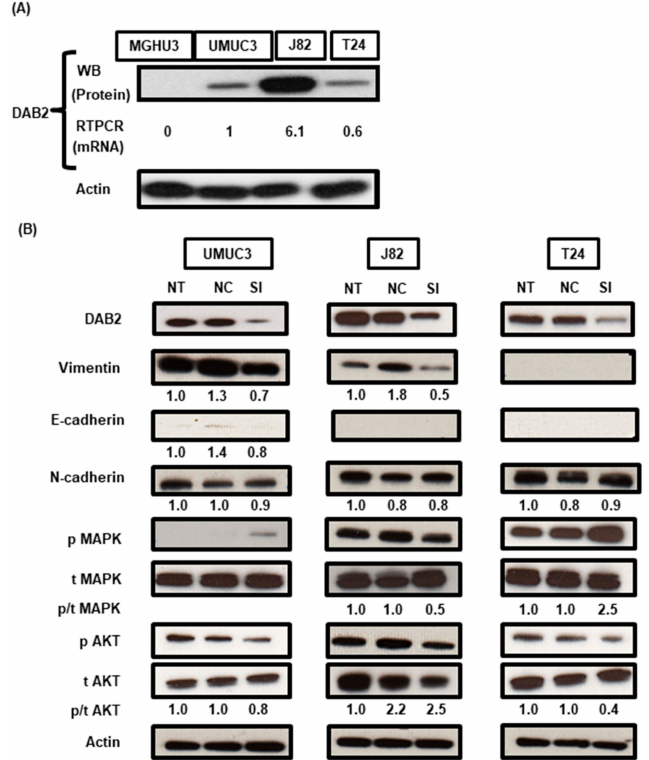
Figure 3. ( A ) In four human UC cell lines, western blot analysis (WB) revealed DAB2 protein expression in UM-UC-3, J82, and T24 cells, whereas MGH-U-3 cells did not express DAB2 protein. The RT-qPCR analysis also revealed mRNA expression of DAB2 corresponded to the results of WB. ( B ) In three cell lines knocked-down with DAB2 siRNA transfection, DAB2 protein reduction was confirmed by WB. Epithelial-to-mesenchymal transition-related markers, proteins involved in the activation of intracellular signaling pathways, were quantified by western blot analysis. Actin was used as a loading control. The numbers below the bands are the results of densitometric quantification. NT: No treatment; NC: Negative control; SI: DAB2 -si